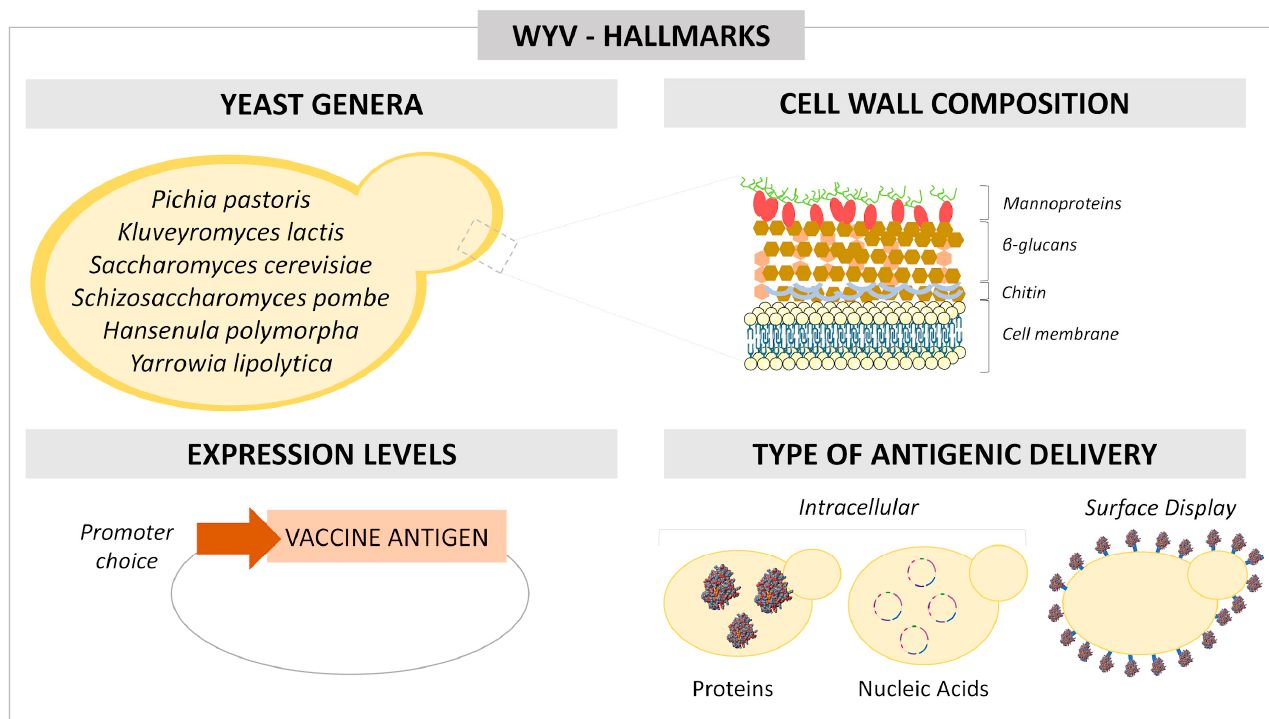
Figure 1. Main hallmarks concerning whole yeast vaccines. These aspects (yeast genera, cell wall composition, target-antigen expression, and the type of antigenic delivery) influence the immune response associated with yeast-based vaccines, as well as their efficacy.